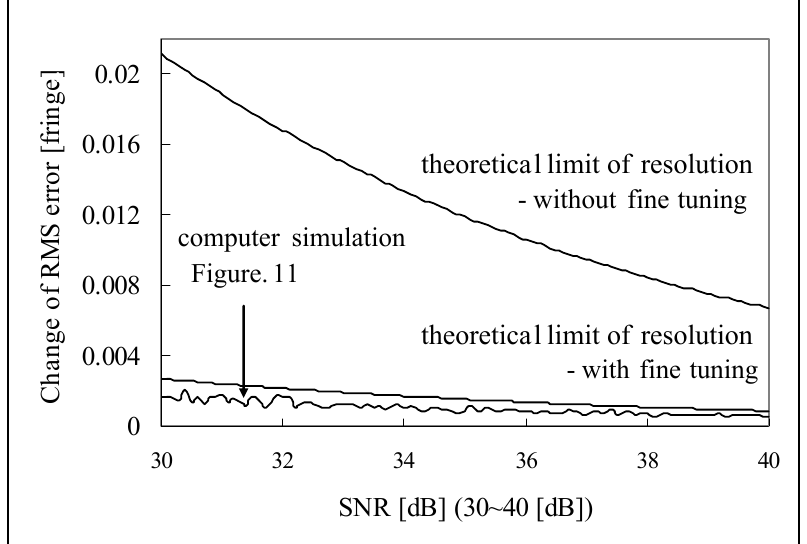
Figure 17 . Comparison of computer simulation and theoretical limit ( SNR : 30-40